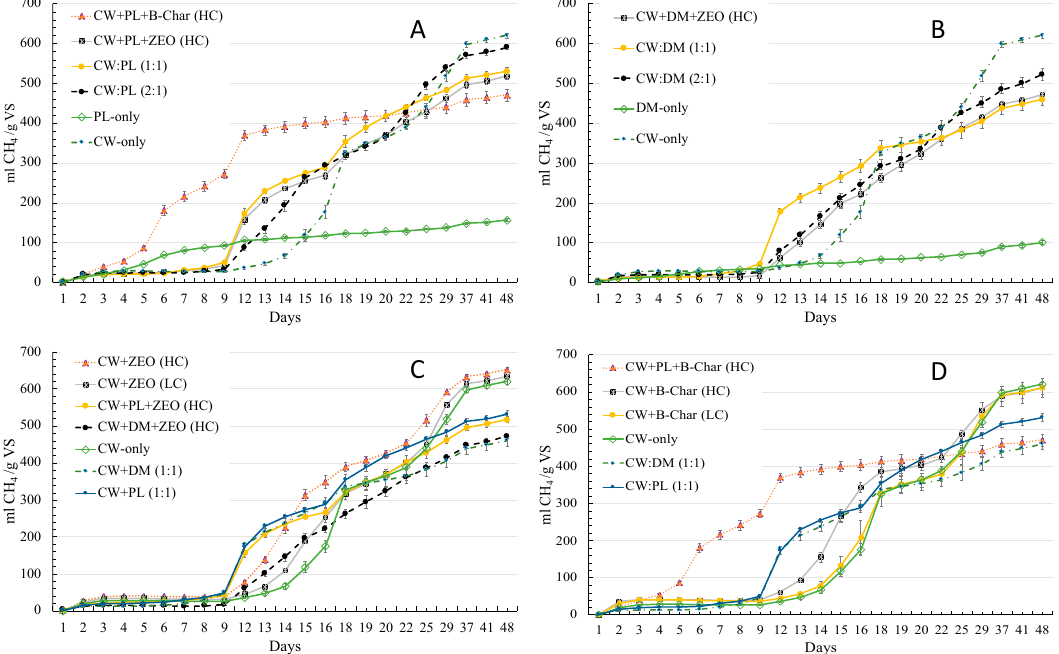
Figure 1. Cumulative CH 4 production based on volatile solids (VS) added to each reactor for cassava wastewater (CW) digested alone and co-digested with poultry litter (PL) shown in ( A ), co-digestion with dairy manure (DM) shown in ( B ), and co-digestion with zeolite (ZEO) and biochar (B-Char) at low and high concentrations (LC and HC) shown in ( C ) and ( D ), respectively.